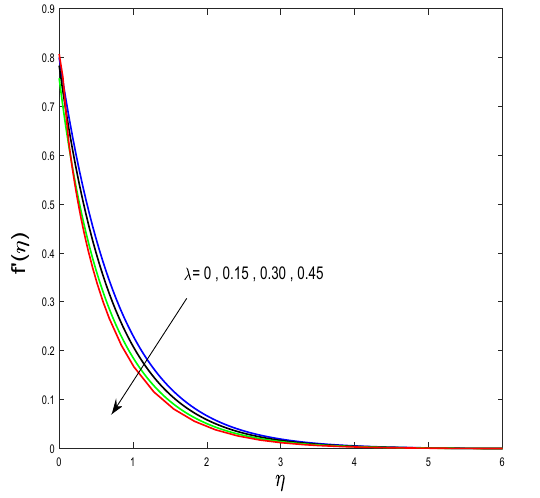
Figure 5. Plot of f ′ for (cid:31) .